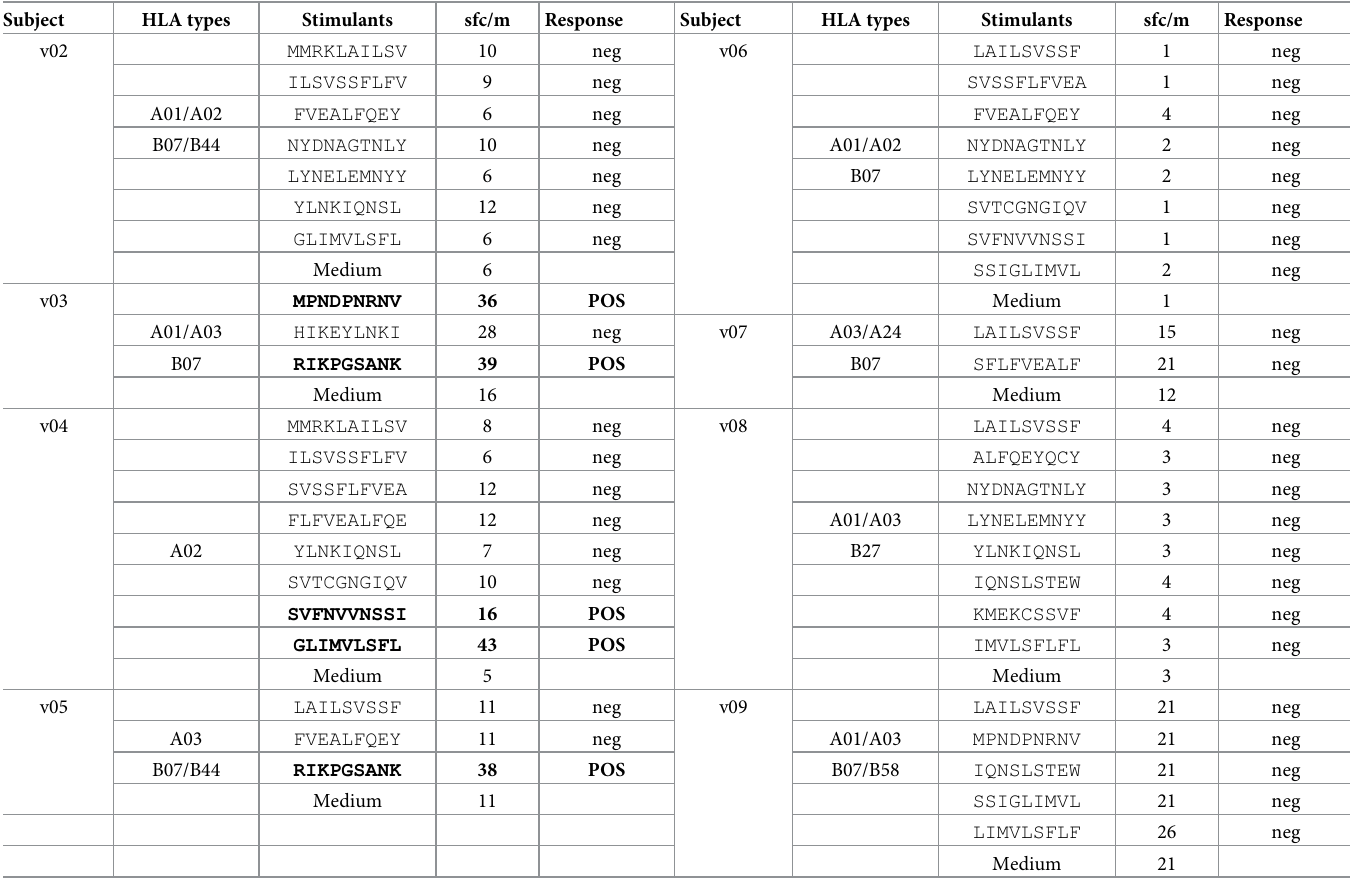
Table 3. Interferon-gamma responses by CD8+ PBMC fractions to the 8-10mer CSP